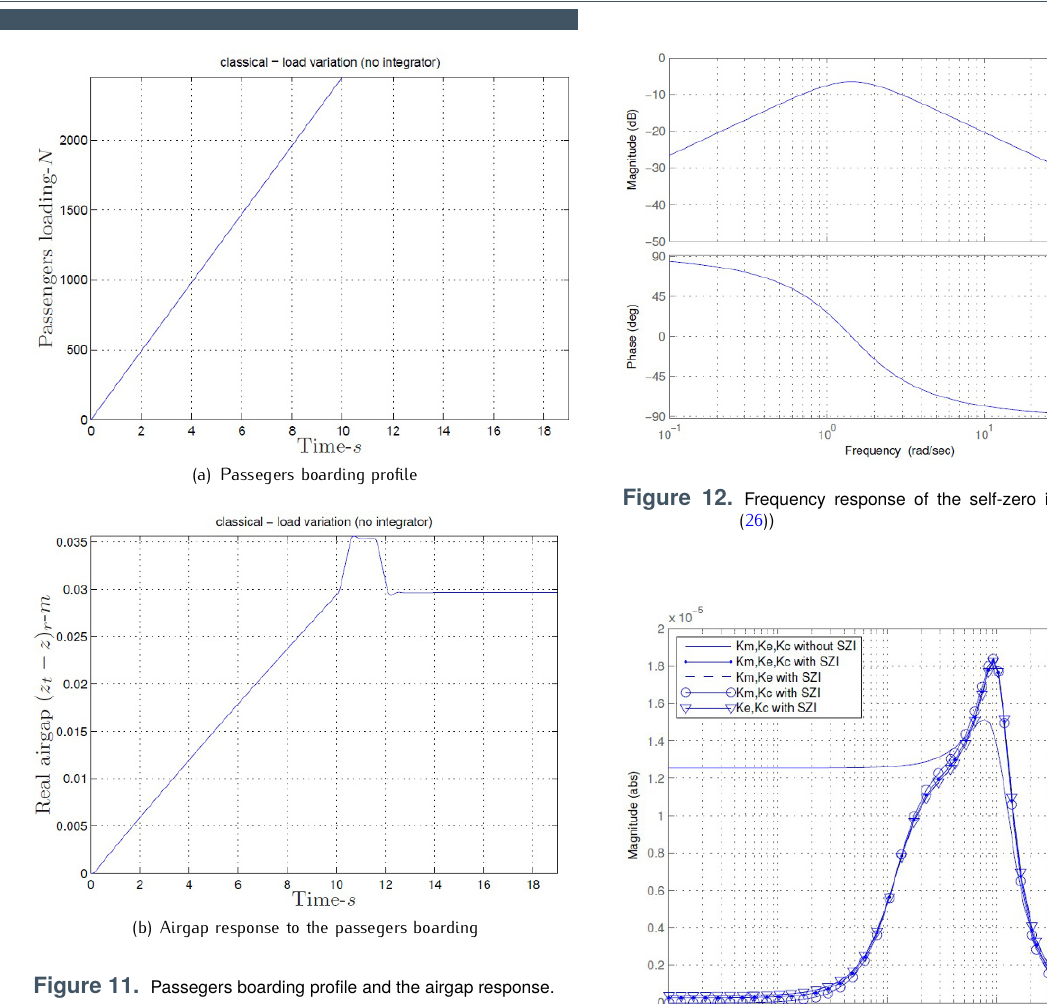
( z t − z ) r and F d with